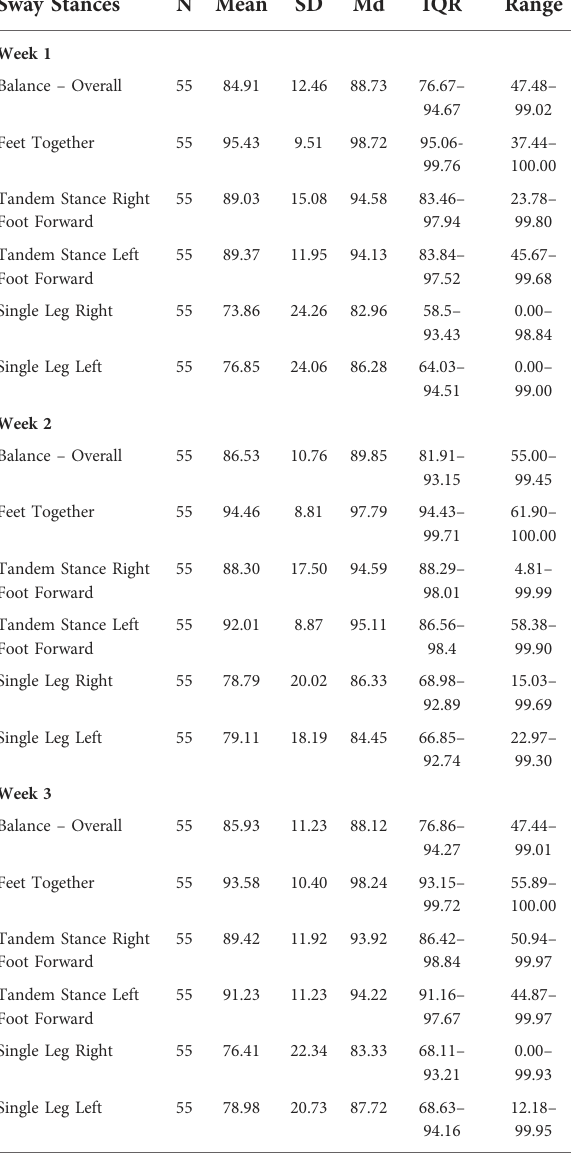
TABLE 1 Descriptive statistics for the Sway Balance